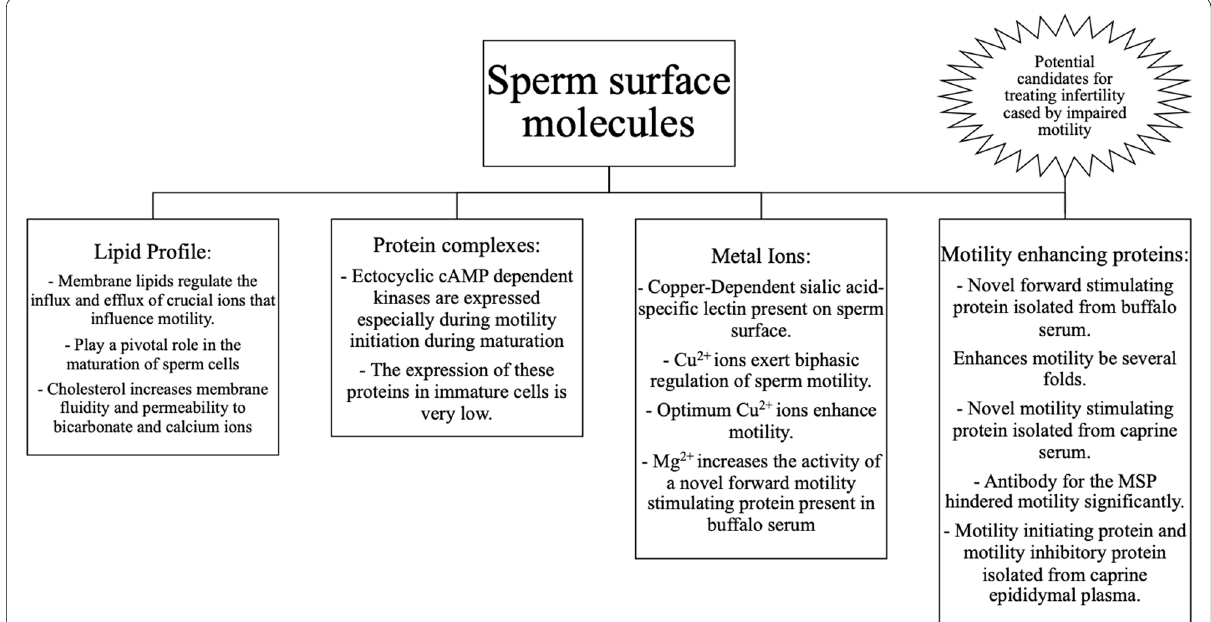
Fig. 3 Summary of the key sperm surface molecules that play an important role in regulating sperm motility. Several novel protein molecules have been found in the serum in buffalo and caprine systems; these molecules interact with their receptors, thus enhancing forward and vertical motility. These molecules can act as novel methods for treating